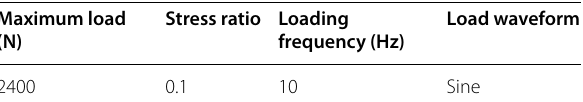
Table 5 Test parameters